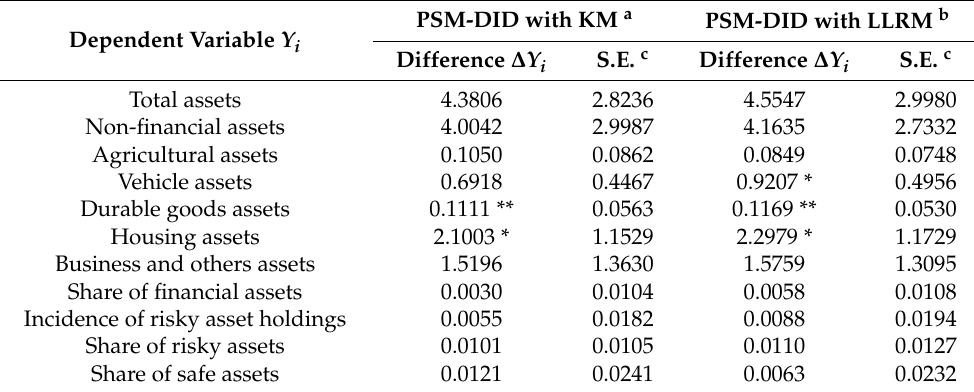
Table 5. Results of land rental market participation on asset allocation of tenant